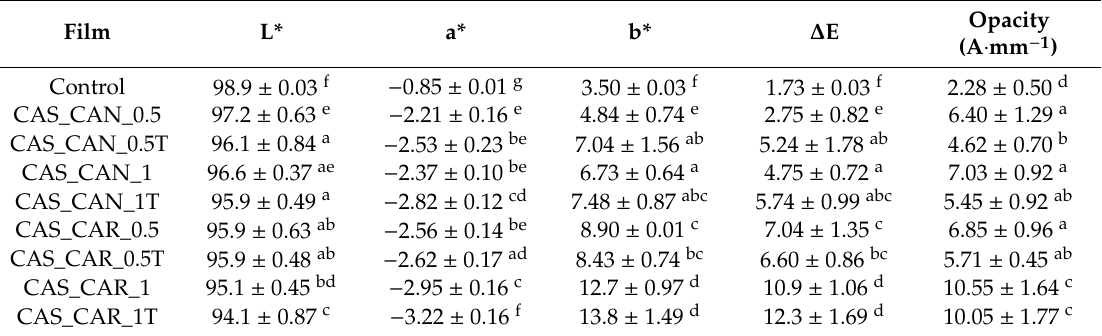
Table 4. L*, a*, b* color parameters, total color di ff erences ( ∆ E), and opacity of sodium caseinate films with candelilla and carnauba